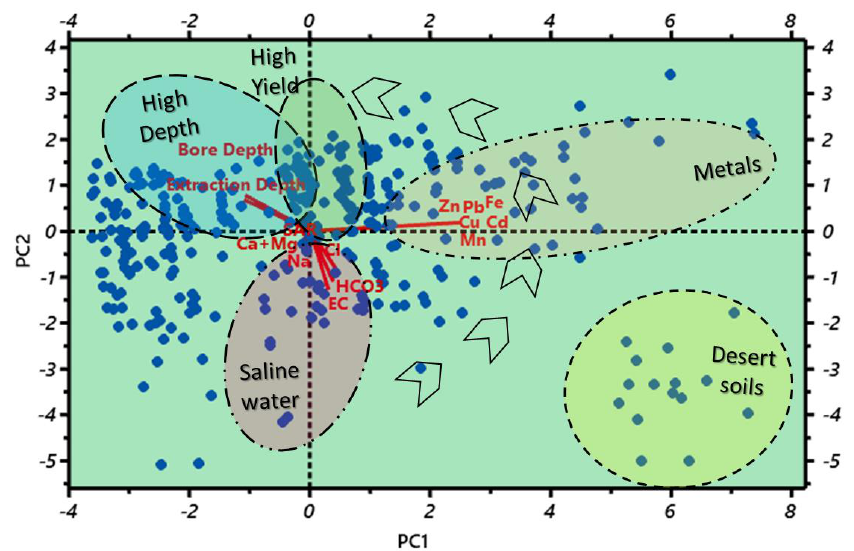
Figure 7. Principal component analysis between physicochemical attributes of groundwater.